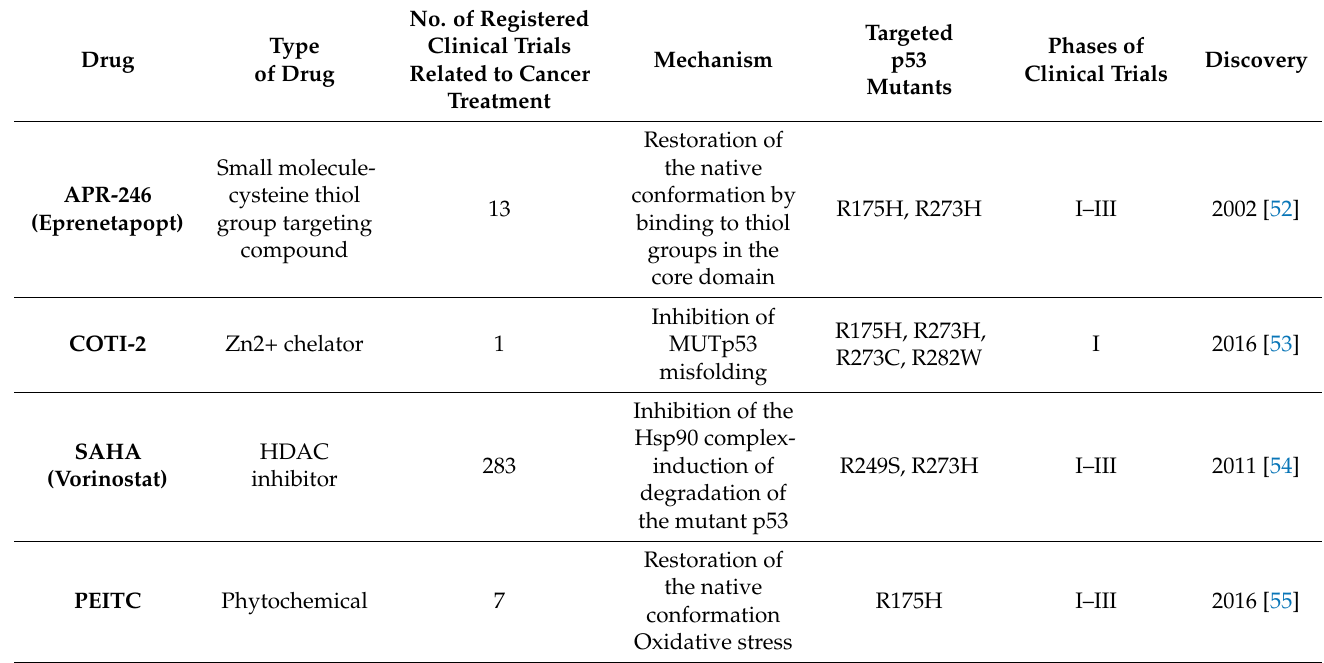
Table 1. Therapeutic compounds currently being investigated in clinical trials related to the treatment of